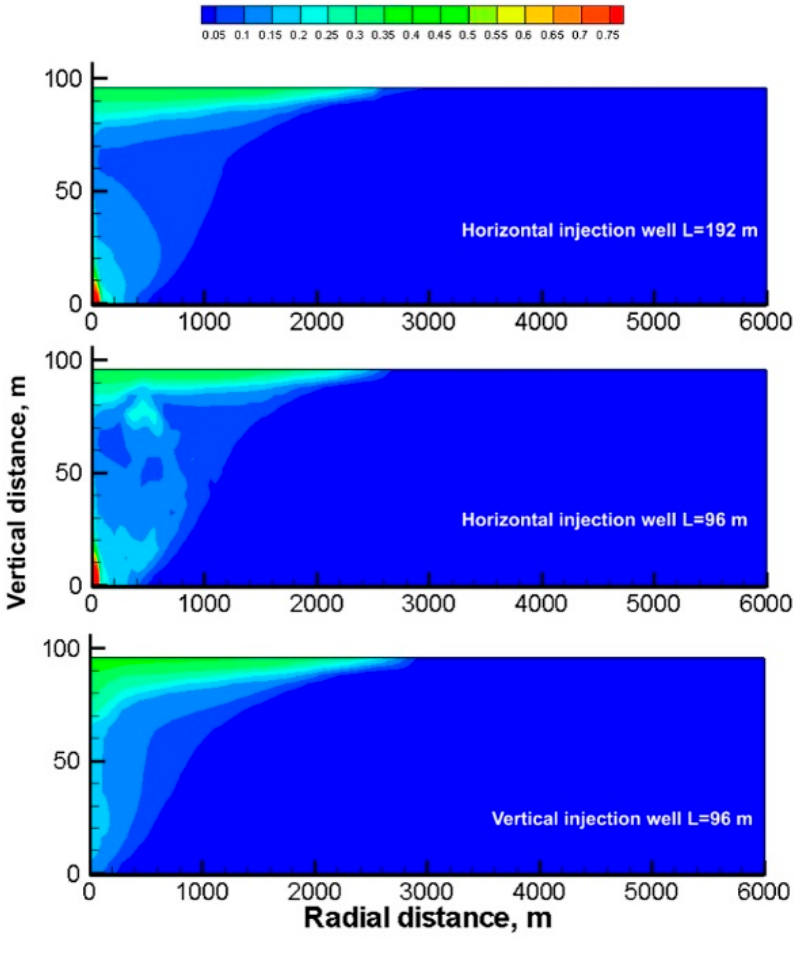
Figure 13. Integrated CO 2 distribution maps for different injection methods after 50 years in a homogeneous domain. Cases 10, 11 and 12 in Table 3.